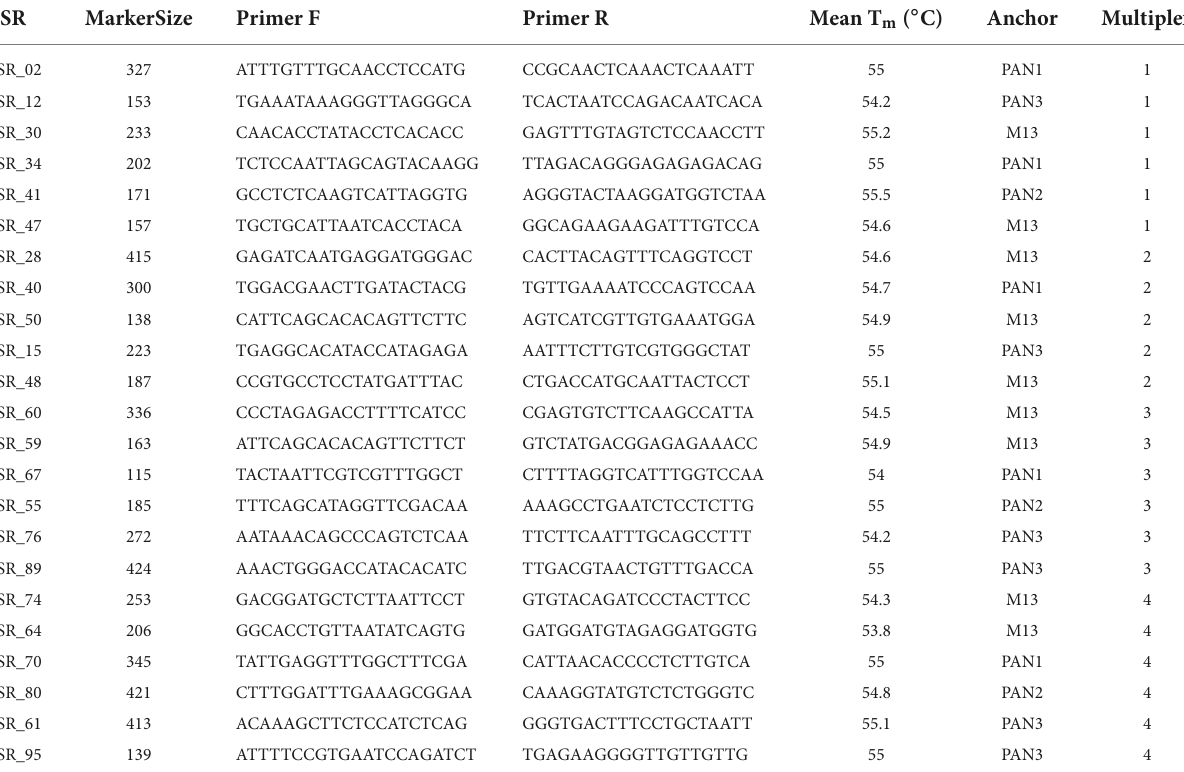
TABLE 1 Information on the 23 microsatellite markers validated using a collection of 55 Mandevilla